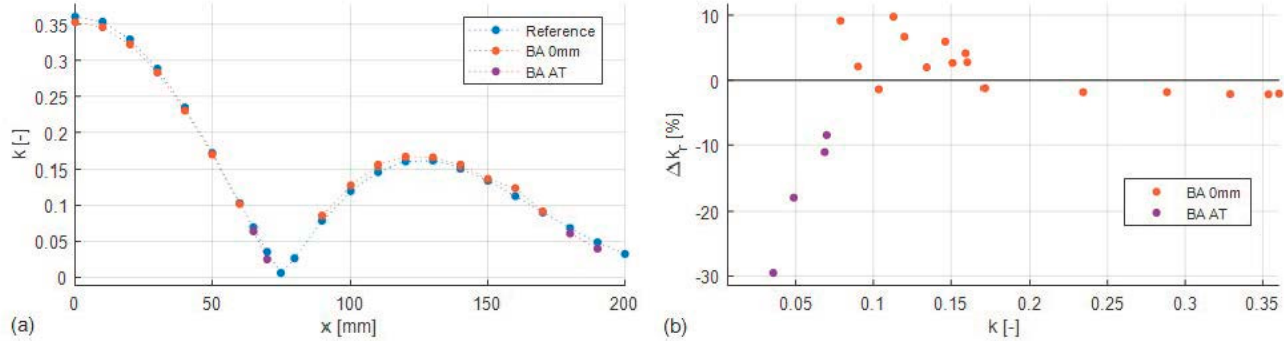
Figure 8. Bifurcation asymptotes method. ( a ) Comparison with the reference measurement. ( b ) Relative error with respect to the reference over k . “BA 0 mm” refers to system tuned for x = 0 mm. “BA AT” refers to system tuned for each misalignment position.